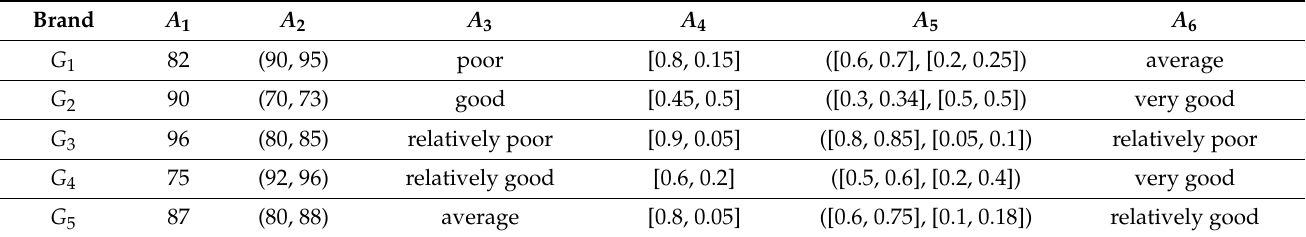
Table 3. The evaluation matrix of expert D 1 .